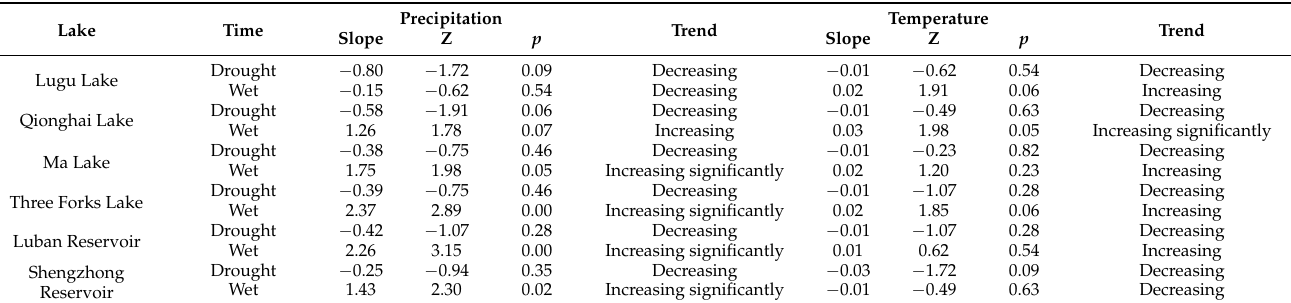
Table 7. Mann–Kendall trend test for meteorological